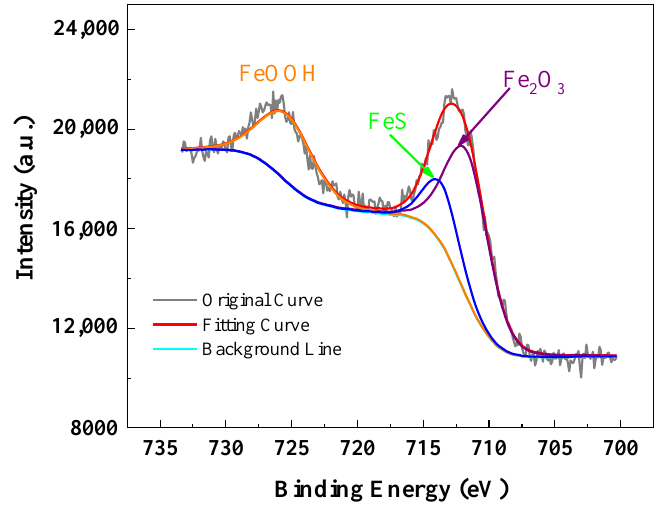
Figure 4. High-resolution XPS spectra of Fe 2p for specimen in the SRB-containing solution after 14 days.